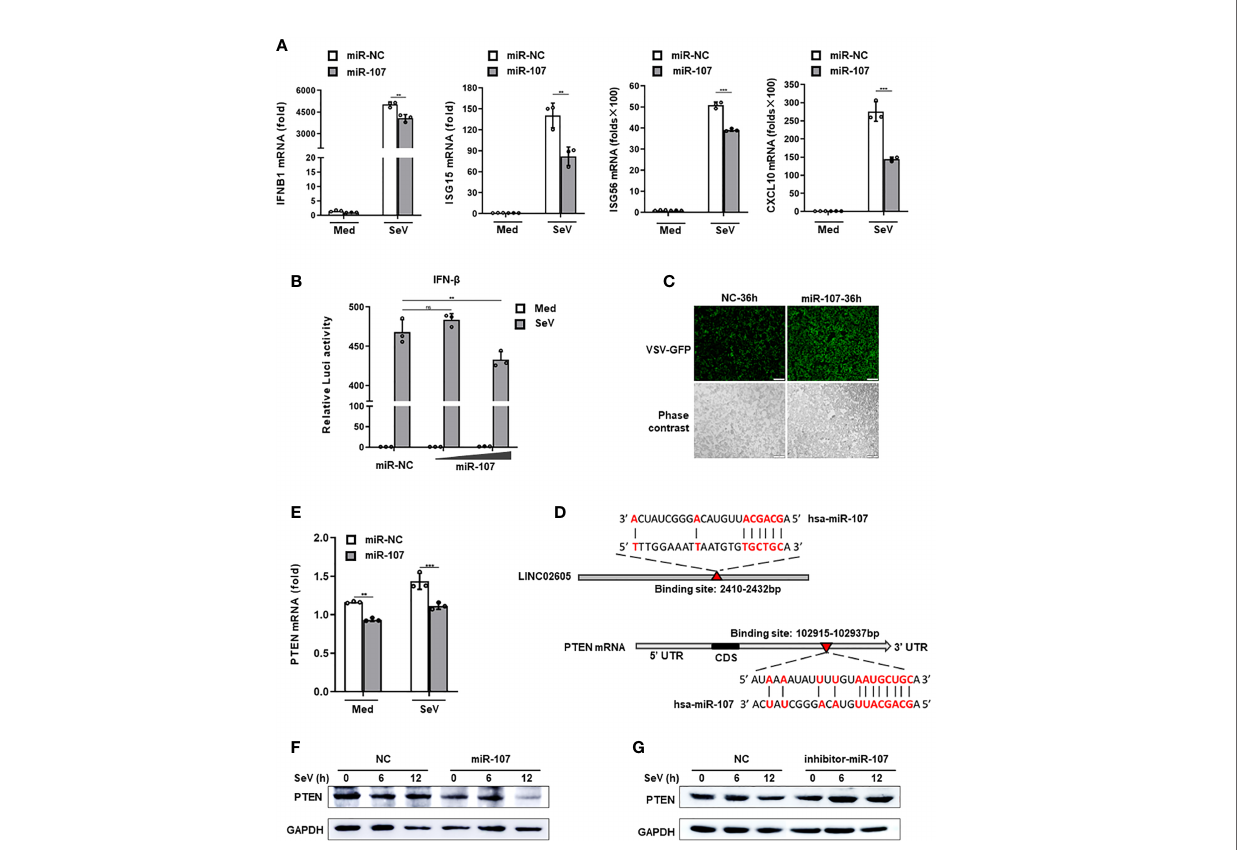
FIGURE 3 | Hsa-miR-107 can negatively regulate antiviral innate immune response and inhibit the expression of PTEN. (A) Q-PCR analysis of IFNB1 , ISG15 , ISG56 and CXCL10 in hsa-miR-107 mimics or miR-NC transfected HEK293T cells upon infection with SeV for 12h. (B) Dual luciferase analysis of the IFN- b promoter activation in HEK293T cells, after co-transfecting hsa-miR-107 mimics with increasing doses (80 nmol/L, 120 nmol/L), or miR-NC, an IFN- b reporter and pRL-SV40 for 24h, then infected with SeV for 12h. (C) Fluorescence analysis of VSV replication in miR-NC or hsa-miR-107 mimics transfected HEK293T cells upon VSV-GFP infection for the indicated hours. (D) The binding sites of hsa-miR-107 on LINC02605 and PTEN were predicted by TargetScan. (E, F) Q-PCR and western blot analysis of PTEN expression in hsa-miR-107 mimics or miR-NC transfected HEK293T cells infected with SeV for the indicated times. (G) Western blot analysis of PTEN expression in hsa-miR-107 inhibitor or NC transfected HEK293T cells infected with SeV for the indicated hours. All data shown are from one representative experiment of at least three independent repeats with similar results. ** P < 0.01 and *** P < 0.001; ns, no signi fi cance (Student ’ s t-test or